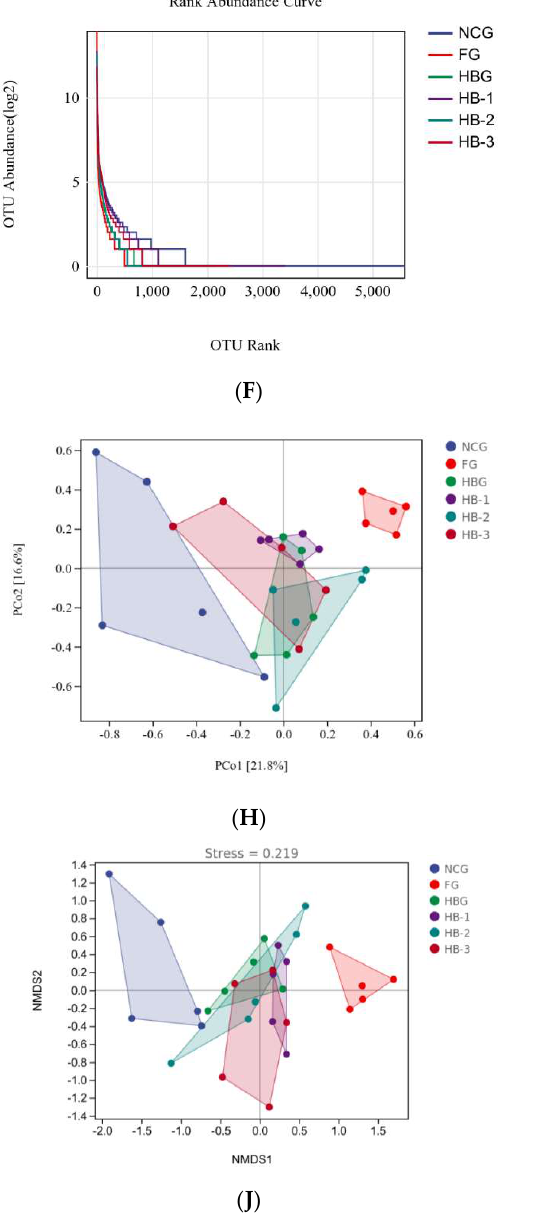
Figure 4. Effect of the six groups on the feces microbiota in HFCD mice. Alpha diversity indexes ( A ), Chao1 rarefaction curve ( B ), Faith’s PD rarefaction curve ( C ), Shannon rarefaction curve ( D ), Pielou’s evenness rarefaction curve ( E ), Rank abundance curve ( F ), PCoA based on bray_curtis distance ( G ), PCoA based on weighted-unifrac distance ( H ), NMDS based on bray_curtis distance ( I ), NMDS based on weighted-unifrac distance ( J ), A Venn diagram showing the overlap of the ASVs ( K ). * indicates a significant difference at p < 0.05.